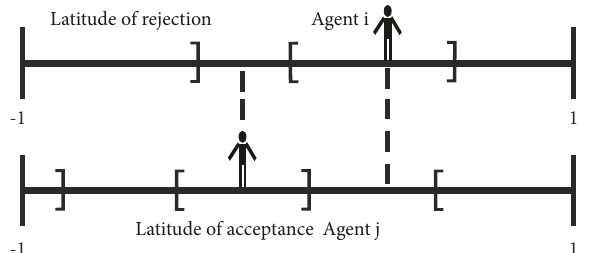
Figure 6: A dyadic interaction between agents 𝑖 and 𝑗 as expressed in (5). Agent 𝑖 ’s opinion falls within agent 𝑗 ’s latitude of noncommit- ment and conversely. Neither agent affects the opinion of the